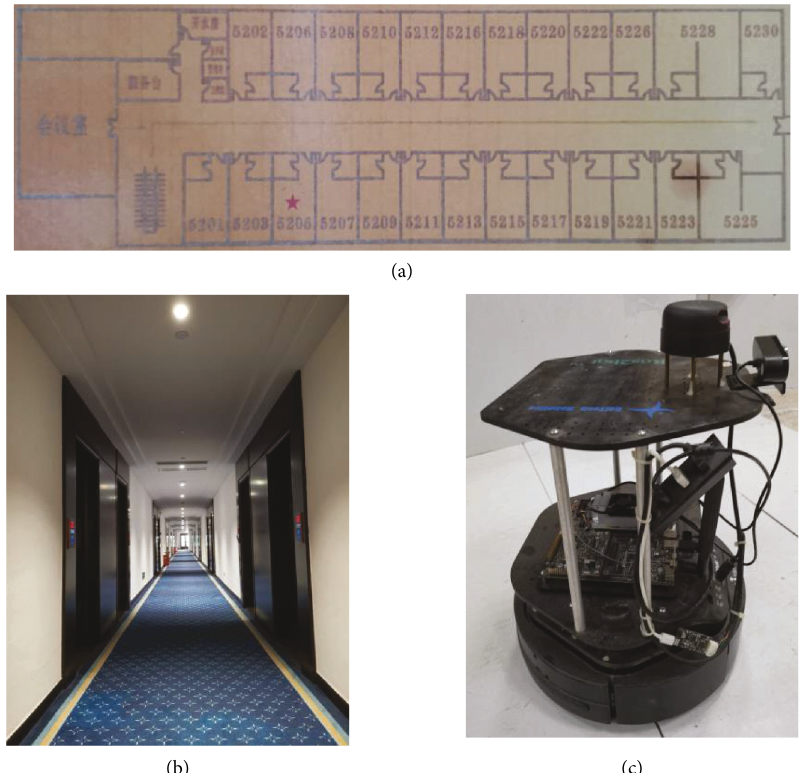
Figure 8: Experimental environment and platform. (a) Floor plan of the second floor of a hotel; (b) corridor image of the second floor; (c) the robot platform.